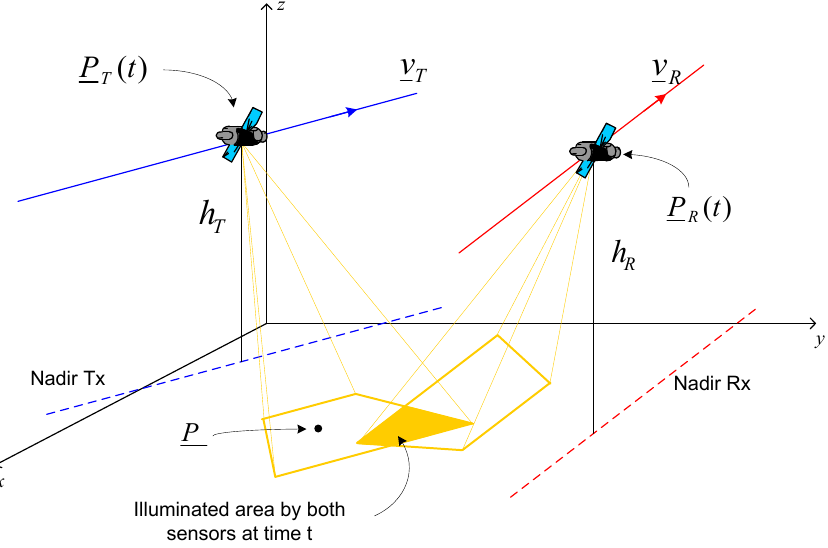
Figure 1. Geometry of the bistatic SAR configuration.